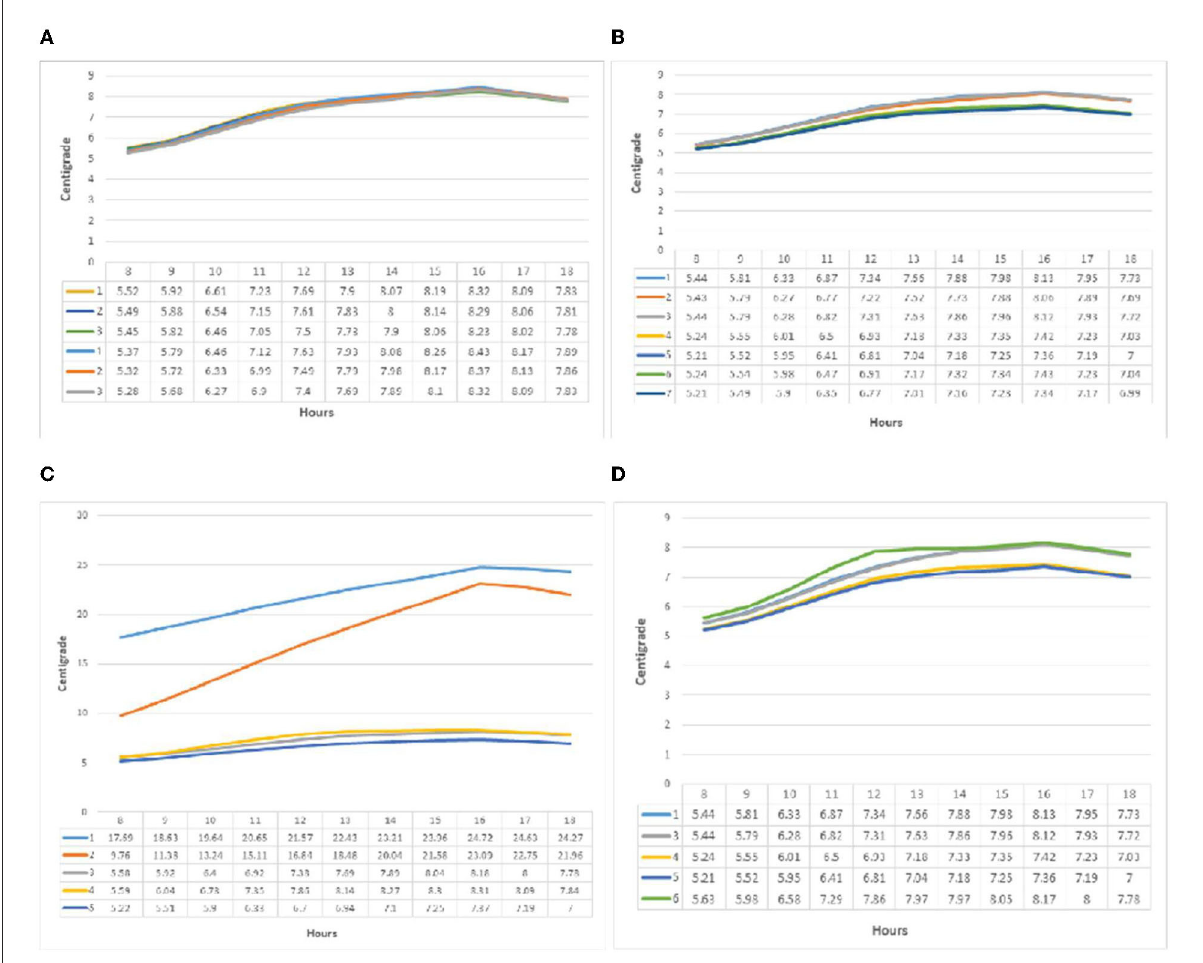
FIGURE7 (A–D) Temperature diagrams from point B in all groups, respectively.